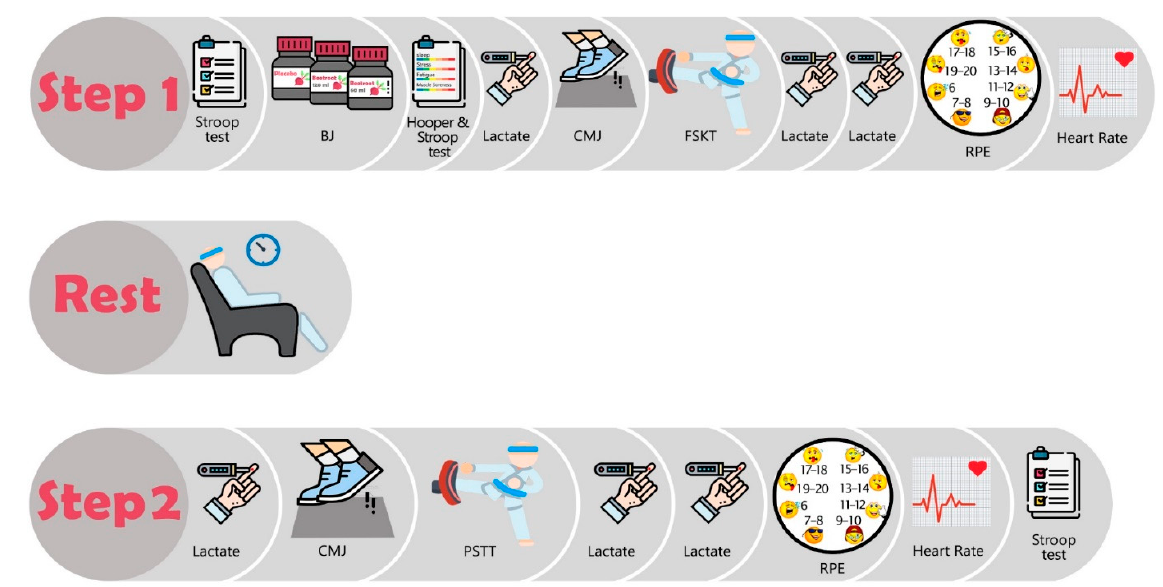
Figure 1. Schematic representation of the experimental design. BJ, beetroot juice; CMJ, counter movement jump; FSKT, Frequency Speed of Kick Test; PSTT, Progressive Specific Taekwondo Test; RPE, rating of perceived exertion.